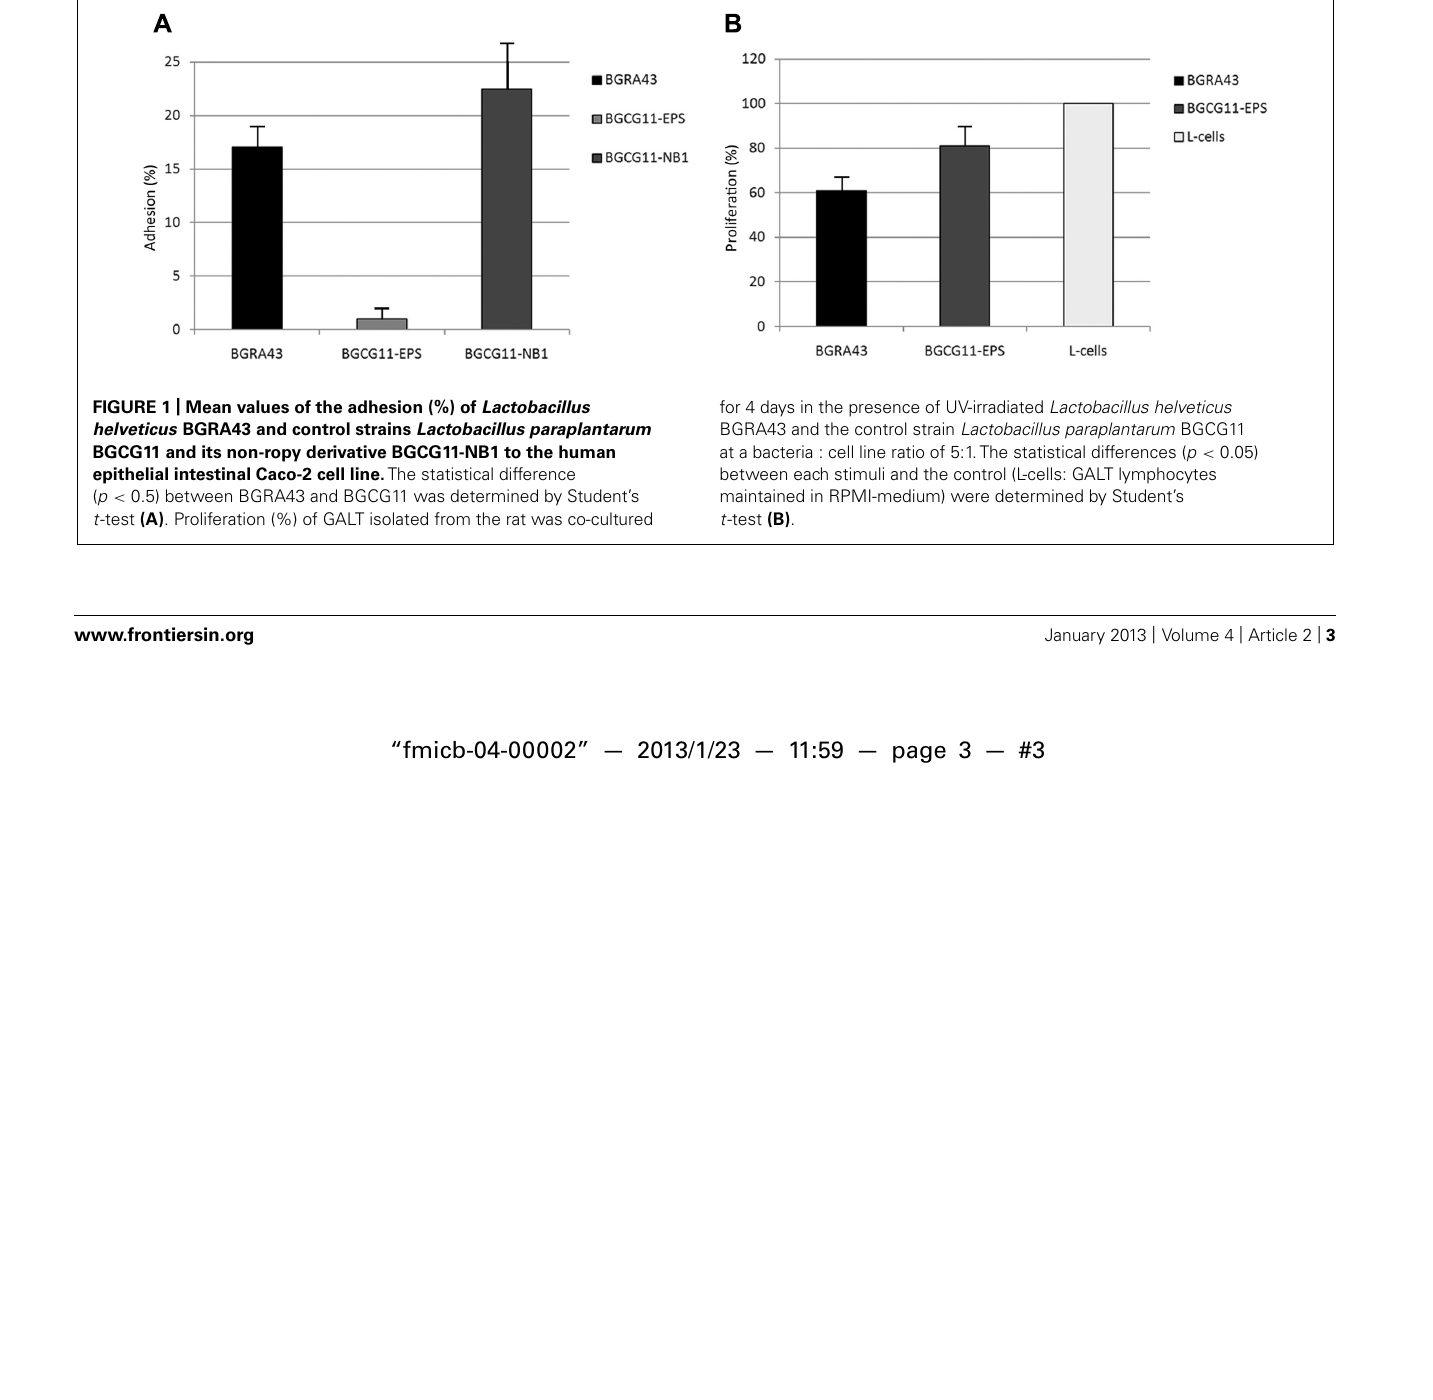
FIGURE 1 | Mean values of the adhesion (%) of Lactobacillus helveticus BGRA43 and control strains Lactobacillus paraplantarum BGCG11 and its non-ropy derivative BGCG11-NB1 to the human epithelial intestinal Caco-2 cell line. The statistical difference ( p < 0.5) between BGRA43 and BGCG11 was determined by Student’s t -test (A) . Proliferation (%) of GALT isolated from the rat was co-cultured